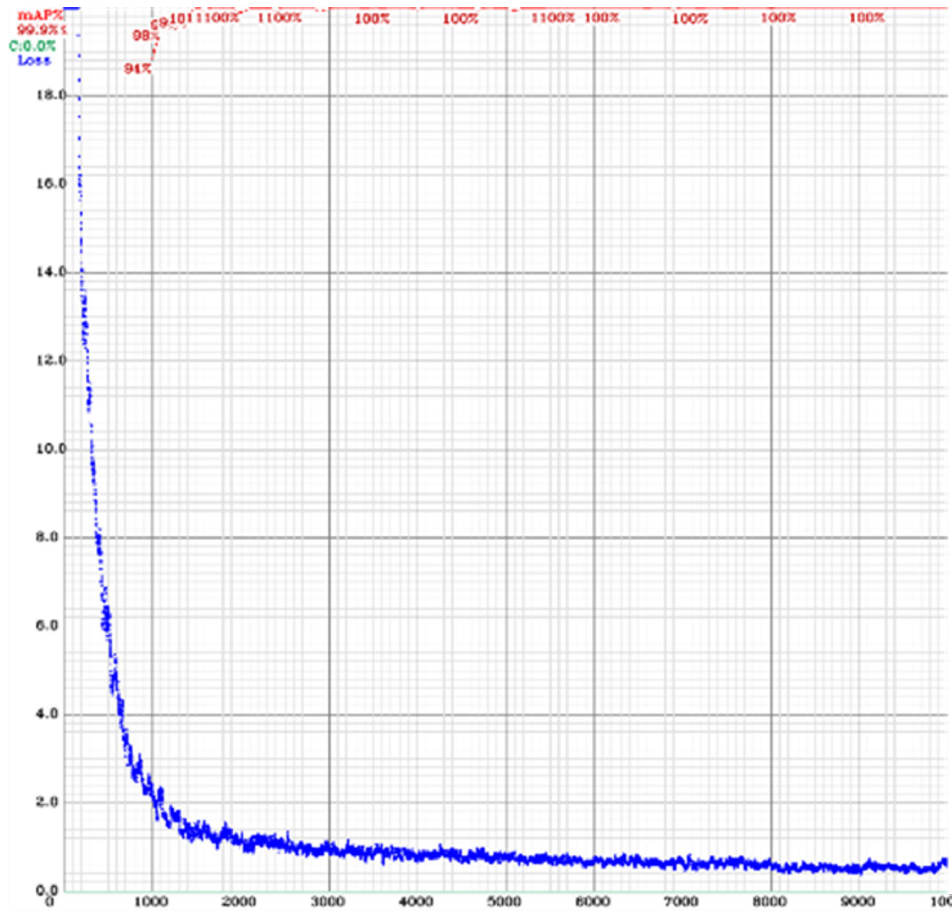
Figure 9. Training curve.